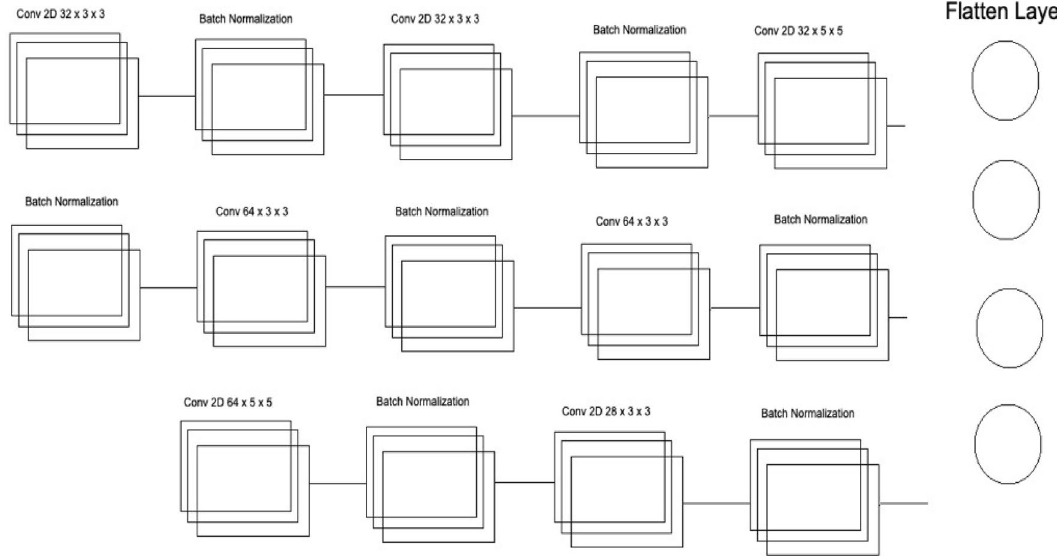
Figure 8. Convolutional neural network three architecture.